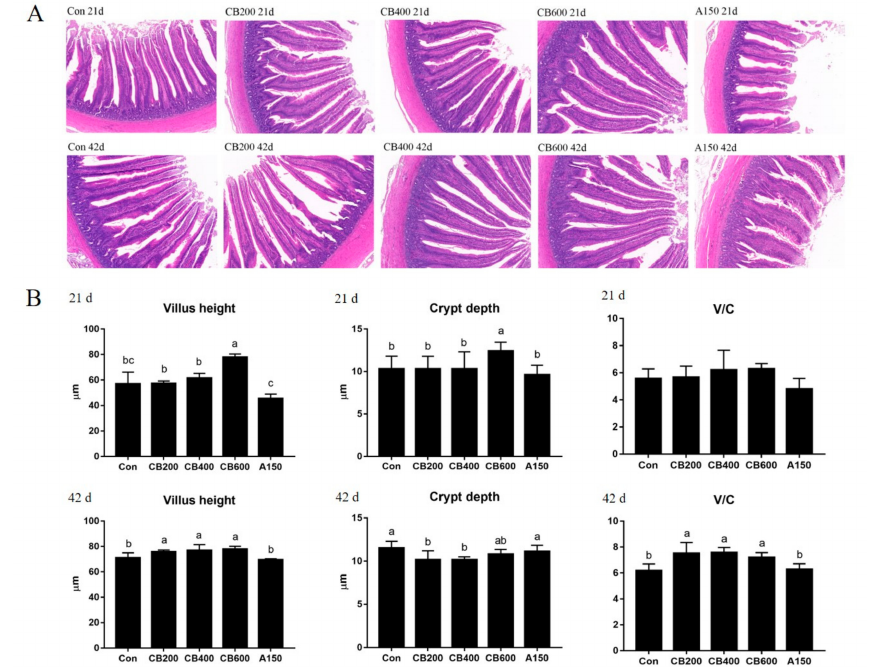
Figure 2. Effects of C. butyricum and aureomycin on intestinal morphology of Pekin ducks. ( A ) H&E staining (50 × ) of intestinal villus. ( B ) The villus height and crypt depth of intestinal villus (N = 10 replicates per group). The data were presented as mean ± SD, the superscript different letters indicate that there are significant differences ( p < 0.05) between any two groups. V/C, the ratio of villus height to crypt depth. Con, group Con; CB200, group CB200; CB400, group CB400; CB600, group CB600; A150, group